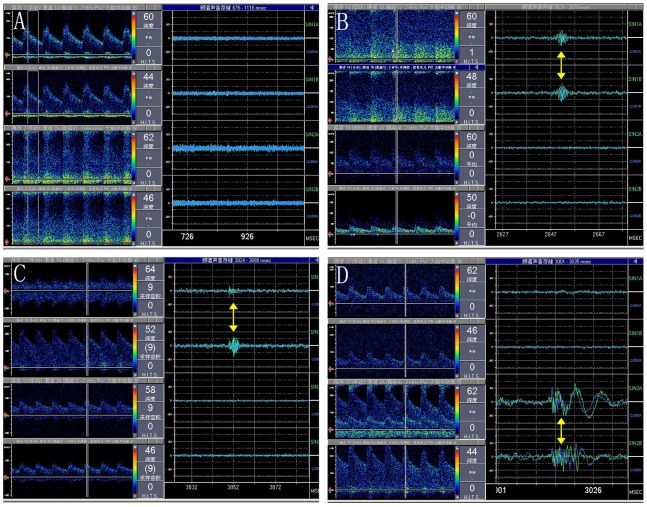
The spectrum of microembolic signal (MES) examination.A was the spectrum of the MES negative (MES−) in a patient with MCA stenosed. And the left were the spectrum of the bilateral MCA in different depths. B and C were the spectrum of MES positive (MES+) in another two patients with MCA stenosis. And we could see the typical MES (the arrow). The depth of investigation of the affected MCA was located at intrastenotic and poststenotic in B, and we could see MES in the two depth. C was located prestenotic and poststenotic areas which we could only see MES in the poststenotic areas (the distal part). D was the spectrum of an atypical MES (the arrow) in a patient with MCA stenosis.